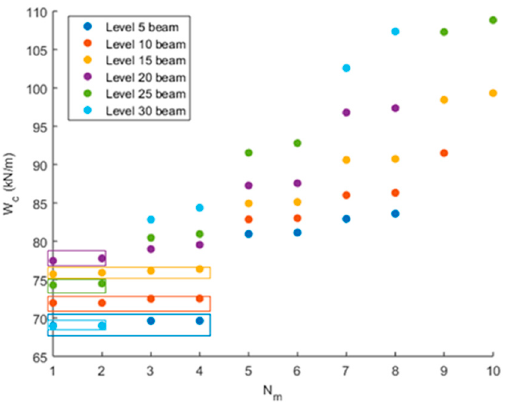
Figure 24. The elastic buckling loads (Wc) of different modes (Nm) for the curved beams on different levels.